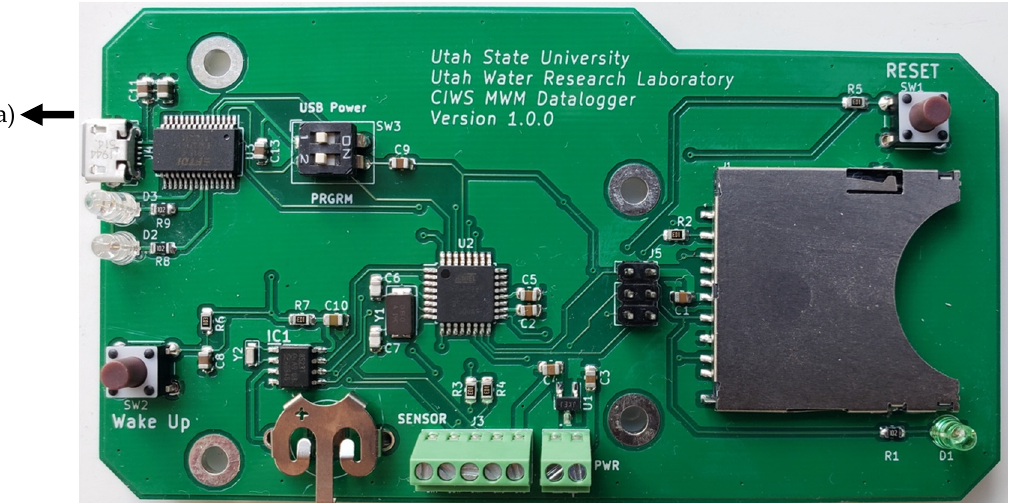
Figure 6. CIWS datalogger built using the printed circuit board (PCB) design developed. (a) Micro-USB connector. Other important components of the datalogger are also observed: the wake up and reset buttons, the sensor and power connections are easily identifiable in the figure by reading the inscriptions included. The SD card adapter, the coin cell battery holder, and LED light are also